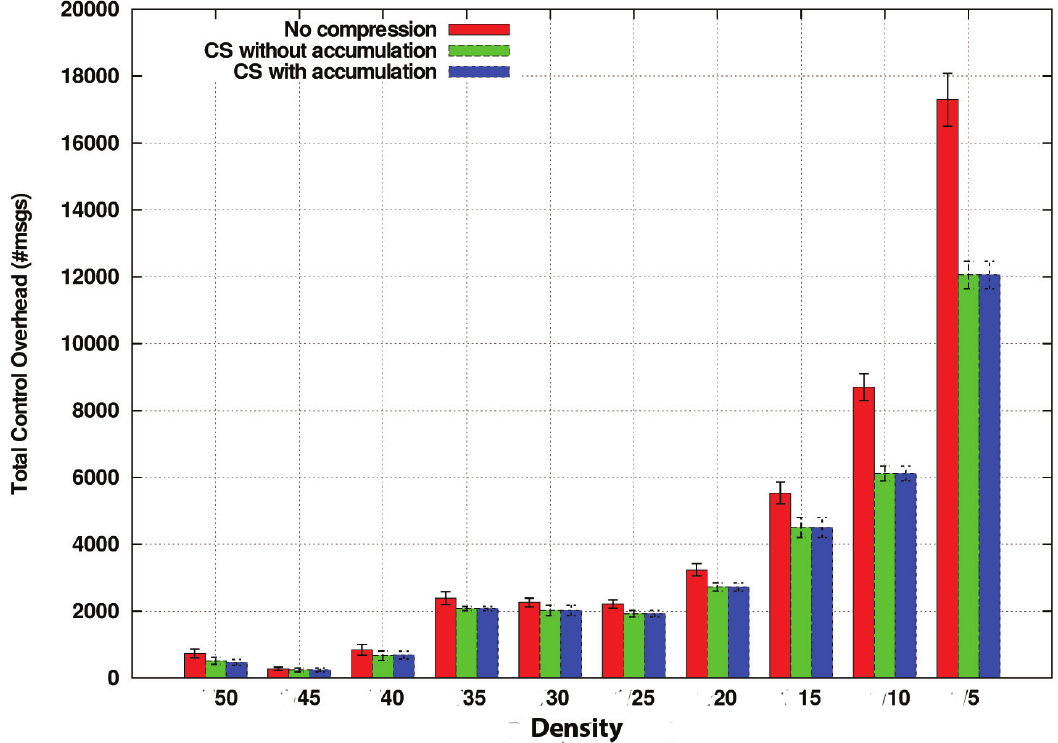
Figure 13. Overhead of compression strategy vs no-compression strategy in msgs for TMAX = 20